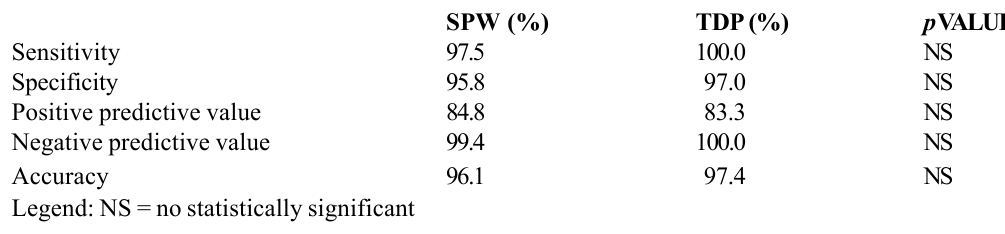
TABLE 2 - Comparison between